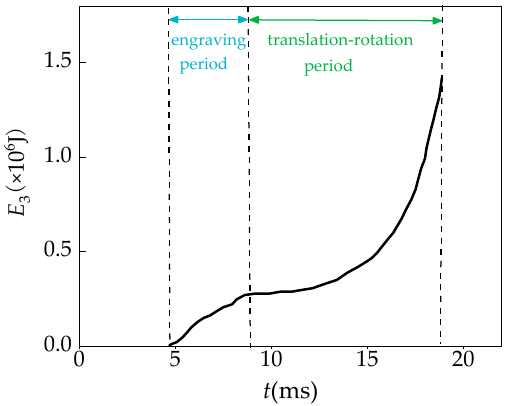
10 of 22 the back rotating band the front rotating band rotating band grooverifling Figure 8. Mises stress and morphology at 6.2 ms in the engraving period.